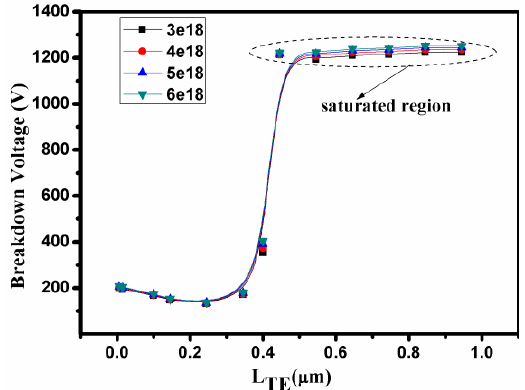
Figure 7. Dependence of the breakdown characteristics on the length of the T anode and the concentration of the acceptor traps of the bottom buffer